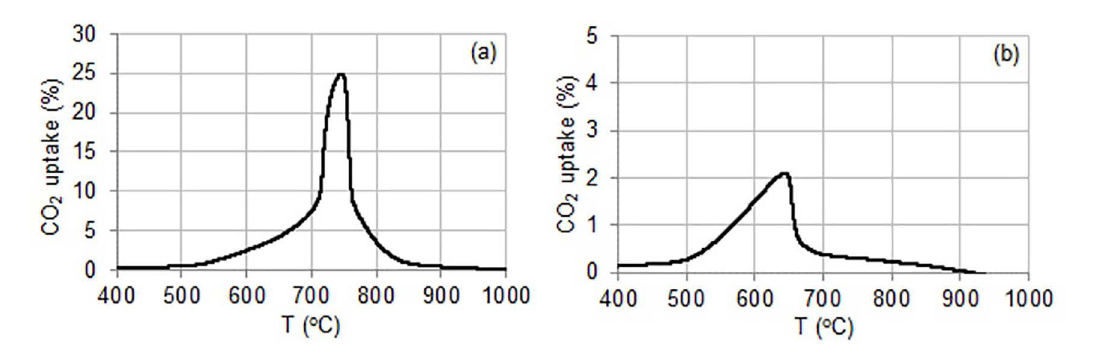
SiO as a function of temperature, for CO 4 4